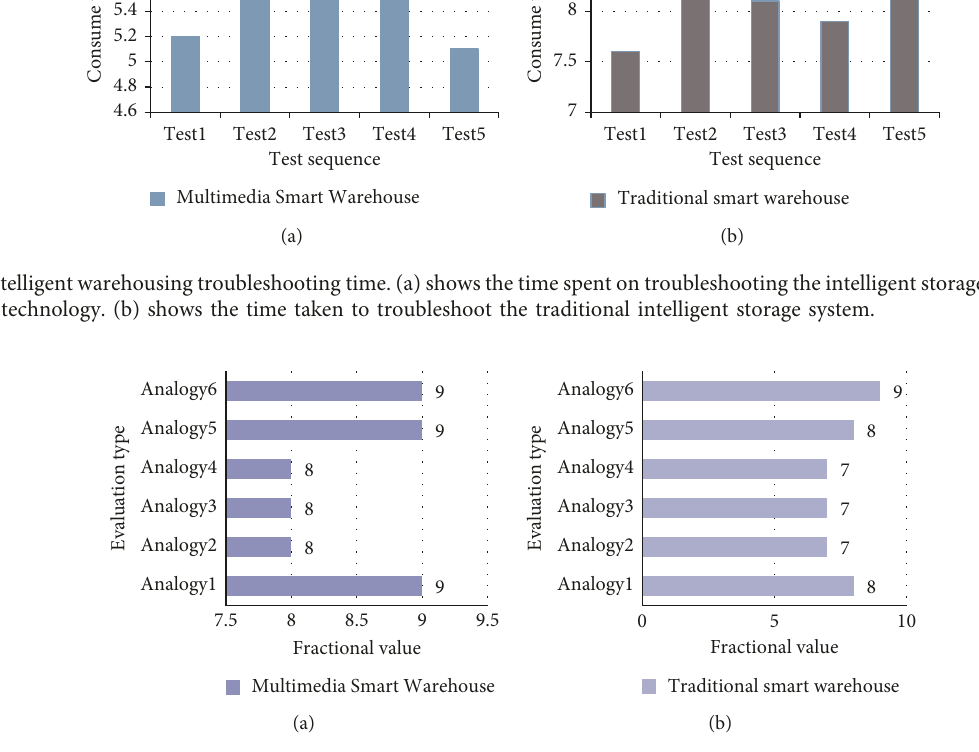
Figure 10: Experience scoring results. (a) is the experience score of the intelligent warehousing system based on multimedia technology. (b) shows the experience score of the traditional intelligent warehousing